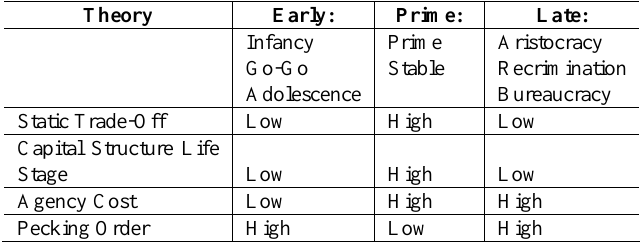
Table 1: The expected level of debt usage in three life stages as predicted by capital structure